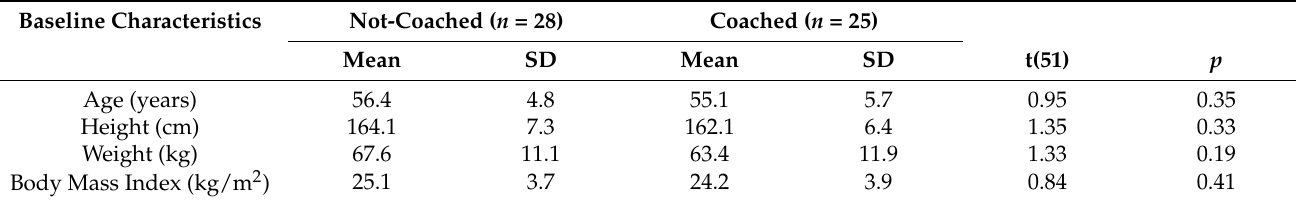
Table 1. Age and Anthropometric Characteristics of Participants at Baseline.